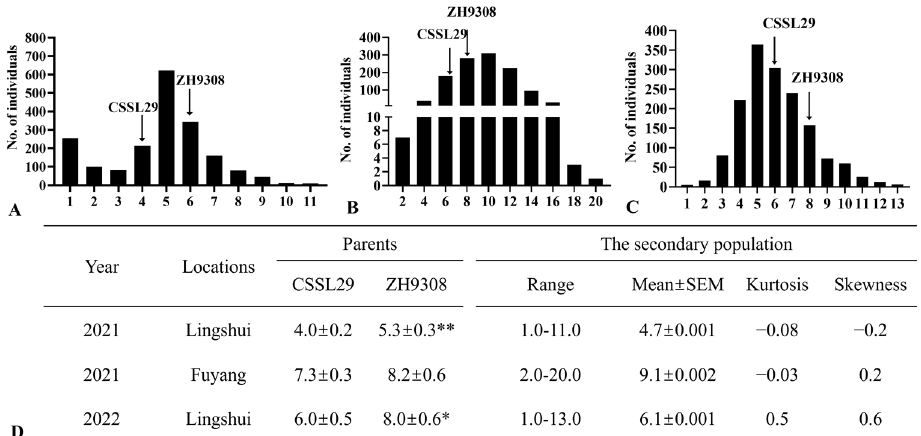
Figure 4. Frequency distribution of tiller number in the secondary population: ( A – C ) frequency distribution of tiller number in the secondary population in Lingshui in 2021, Fuyang in 2021, and Lingshui in 2022, respectively; and ( D ) the phenotypic performance of the parents and the secondary population. The CSSL29 was regarded as reference. * p < 0.05, ** p < 0.01, Student’s t -test.